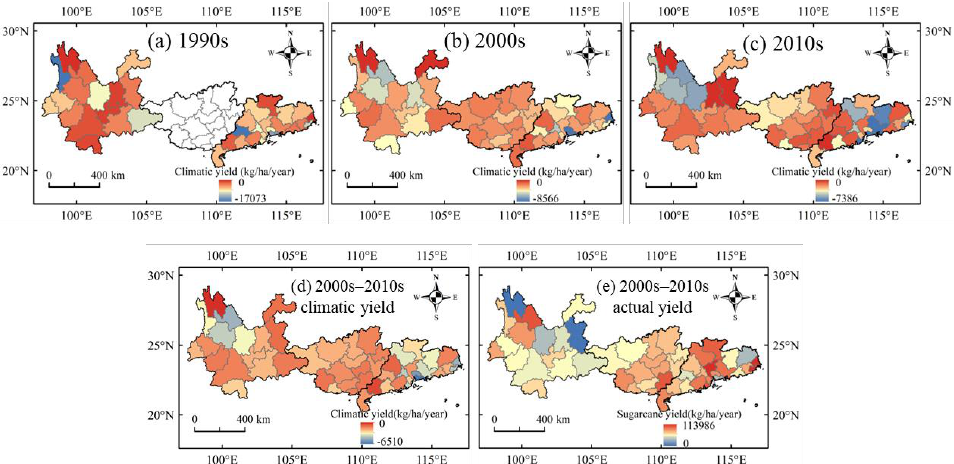
Figure 10. Sugarcane climatic yield (kg/hg/year) during 1990s ( a ), 2000s ( b ), 2010s ( c ), and 2000s – 2010s ( d ), as well as actual sugarcane yield during 2000s – 2010s ( e ) in southern China. Negative values of sugarcane climatic yield were used here to describe sugarcane yield losses. Guangxi has no yield data in the 1990s, so only Yunnan and Guangdong were included in Figure 10 (a). As shown in Figure 11a, for sugarcane drought, the relationships between drought intensity and sugarcane climatic yield were found to be significant in four districts (i.e., Meizhou and Dongguan in Guangdong, and Beihai and Laibin in Yunnan). Two of them (in Dongguan and Laibin) were negative and reached the significance of p < 0.01, indicating a yield-reducing effect of sugarcane drought. However, the remaining two significant results were positive (in Meizhou and Beihai), implying positive relationships between sugar drought intensity and climatic yield. In Guangxi and Yunnan, the number of negative correlations was more common than positive correlations; however, more positive results existed in Guangdong. Therefore, the effects of drought on sugarcane yield were not simply negative at the reginal scale. Differing from sugarcane drought, sugarcane flood intensity was majorly negatively related to sugarcane climatic yield in all the three provinces (Figure 11b). Moreover, there were three significant results (Huizhou, Puer, and Beihai; Beihai was significant at p < 0.01) — all of them negative — which demonstrated the obvious yield-reducing effect of sugarcane flood. For sugarcane HT (Figure 11c), the relationships of HT intensity vs. sugarcane climatic yield were generally weak, and no significant relationships were found.